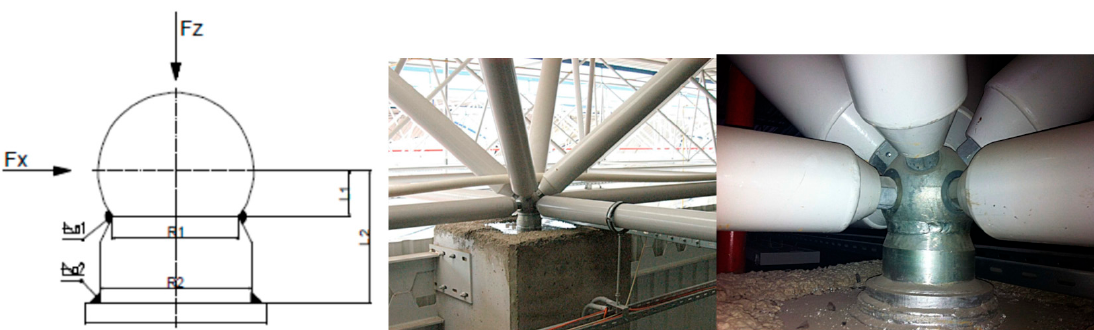
Figure 5. View of the spherical joints and the supports.